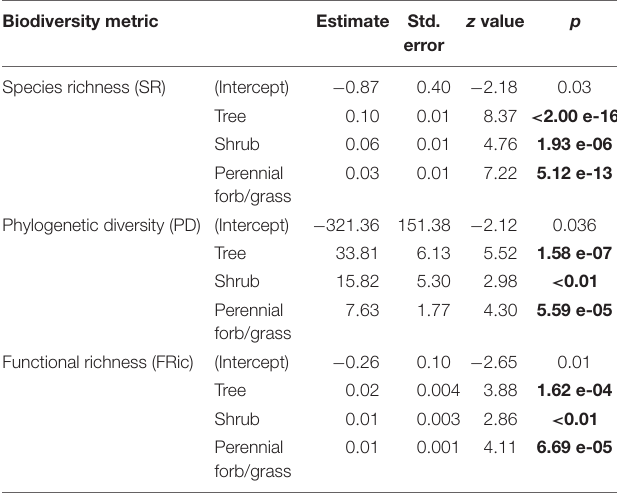
TABLE 2 | Models describing the relationship between raw and fitted values of avian community diversity and remotely sensed vegetation metrics from the Rangeland Analysis Platform (Allred et al.,